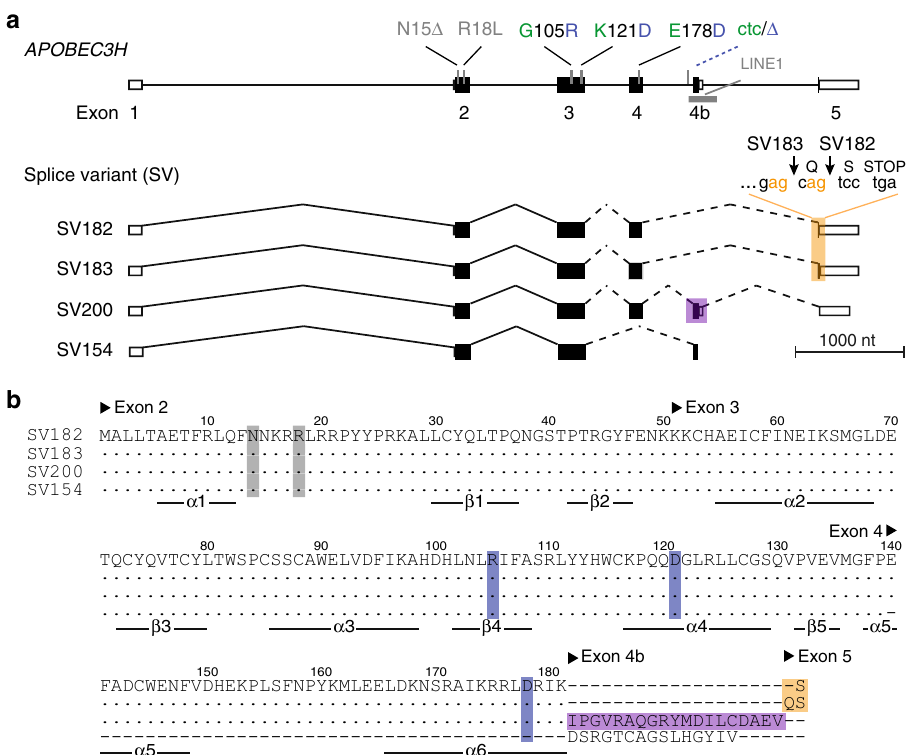
Fig. 1 Human A3H genetic variation. a Schematic of the 5 exon human A3H gene with key coding and non-coding variations. Haplotype I and II variations are colored green and blue, respectively. The four different splice variants are shown below with orange shading to highlight the tandem splice acceptor that distinguishes SV182 and SV183 and purple shading to highlight the alternatively spliced exon 4b in SV200. b An amino acid alignment of each of the different splice variants encoded by the A3H haplotype II locus. To correspond with labels in a , variable amino acid positions are shaded gray or blue and alternative splicing products are shaded orange or purple. Exon positions are indicated above the amino acid alignment and secondary structures elements below Table 1 APOBEC3H haplotypes and frequencies from analyses of 1000 Genomes Project data ( n = 2504) APOBEC3H